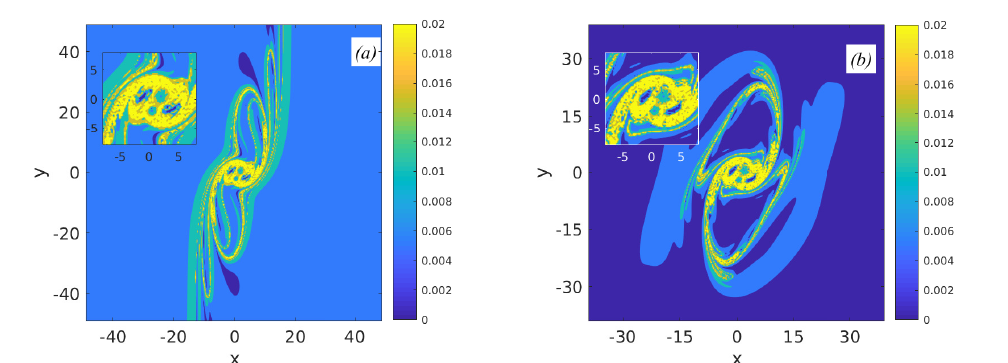
Figure 21. Instantaneous distributions of Finite-Time Lyapunov exponents for the case of: ( a ) parametric instability manifestation; and ( b ) no parametric instability. The darker the region is, the more intensely local stirring of fluid particles